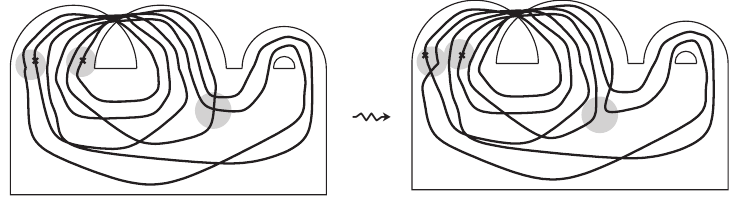
Figure 5.5 . Applying Step 1 to the leftmost point of p Σ (K) ∩ I